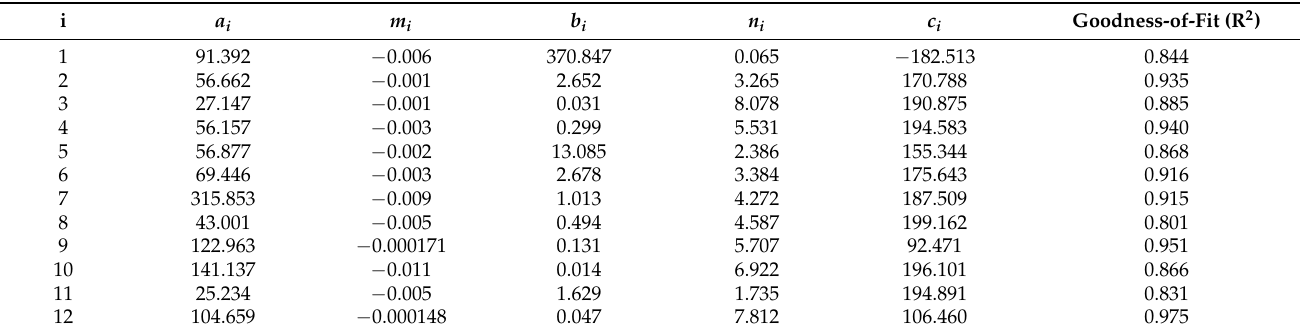
Table 2. Parameters of the measurement models for the carbon dioxide emission factors.